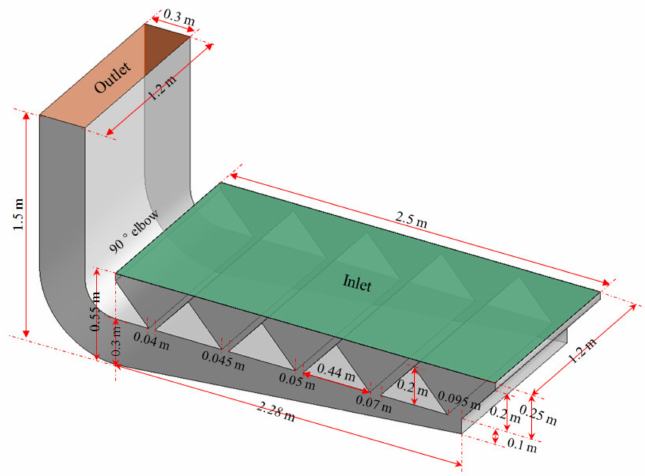
Figure 4. Lower exhaust workbench used for experimental